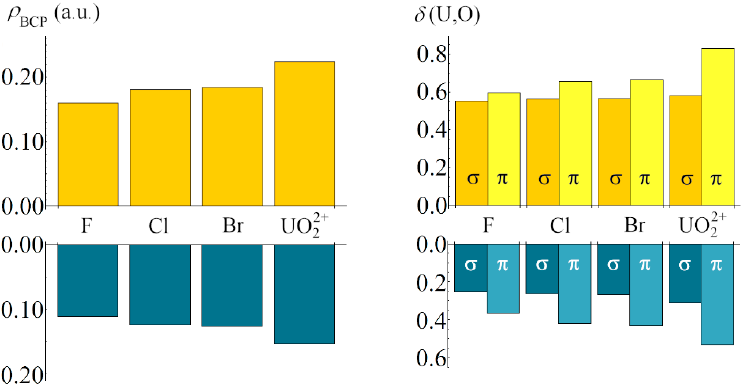
Figure 2. Decomposed QTAIM metrics of the U-O bond in [UO 2 X 4 ] 2 − complexes (X = F, Cl, Br) obtained from B3LYP-derived densities. Values from free uranyl are also provided for comparison. f-shell contributions are given in yellow and d-shell contributions are given in blue.